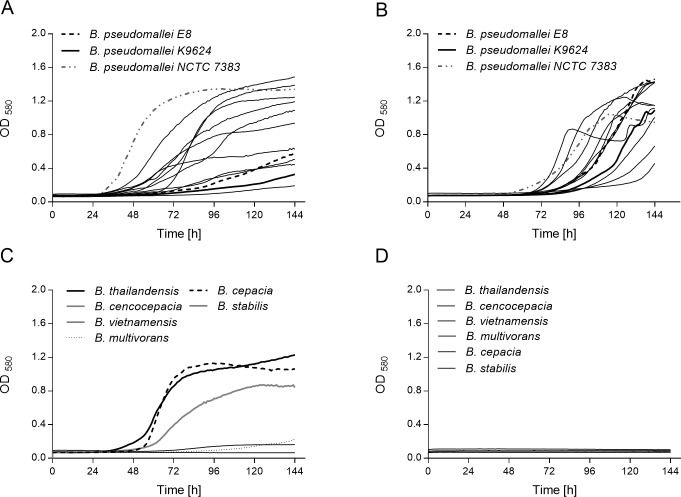
Growth of Burkholderia pseudomallei and other soil- dwelling bacteria in TBSS-C50 and erythritol medium (EM).Different B. pseudomallei and several other soil-dwelling bacterial strains were cultivated for 144h at 40°C in TBSS-C50, EM or EM without colistin. Bacterial growth was monitored by measuring the absorbance of the cultures at 580nm hourly. (A) Growth of B. pseudomallei strains in TBSS-C50. In the interest of clarity, only the isolates K9624, E8 and NCTC 7383 mentioned in the text are specifically labelled. The remaining nine tested isolates are listed in Table 1. (B) Growth of B. pseudomallei strains in EM. (C) Growth of non- B. pseudomallei strains in TBSS-C50. (D) Growth of non- B. pseudomallei strains in EM medium without colistin. Each growth curve is representative of two independent experiments with similar results. Each experiment was conducted in technical duplicates.